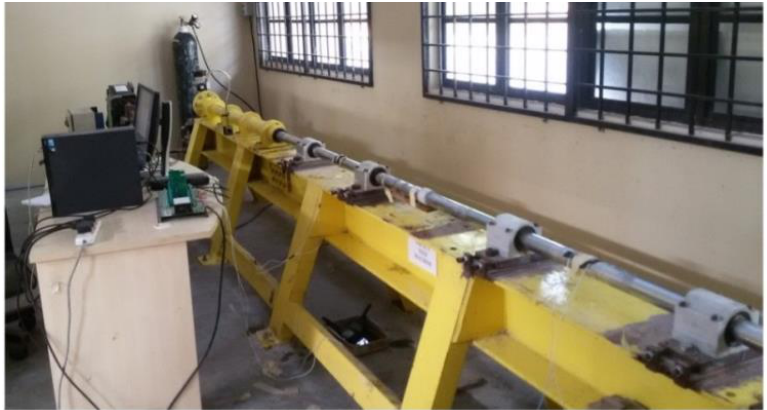
Figure 2. Split Hopkinson pressure bar (SHPB) machine components.